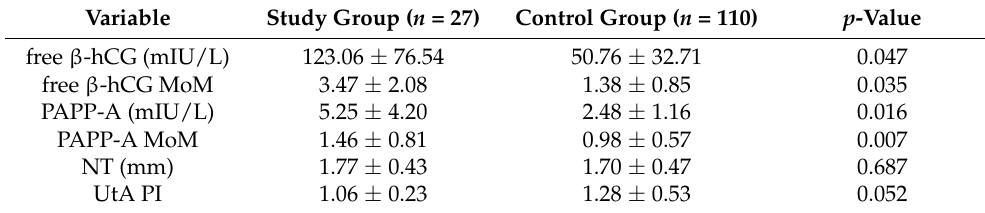
Table 3. The comparison of first-trimester screening parameters in study and control groups. Variable